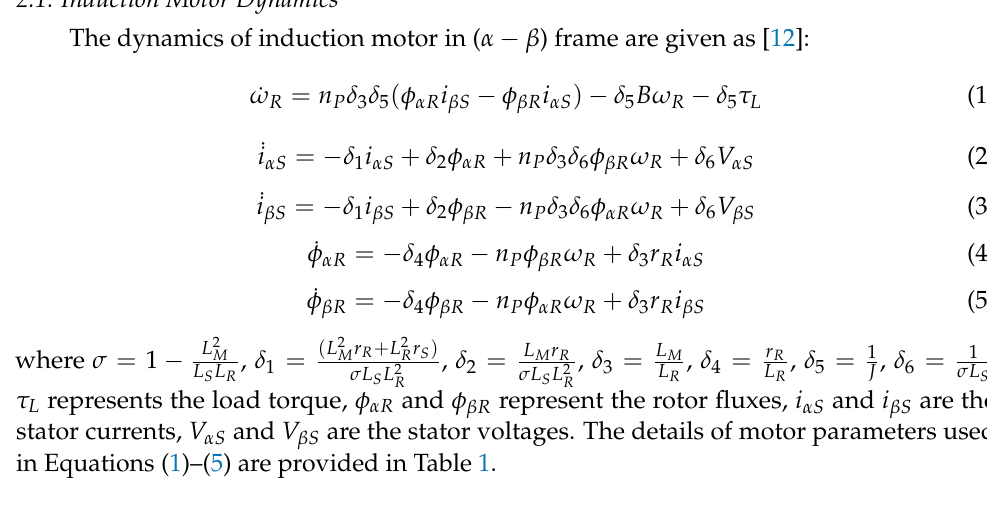
Table 1. Motor parameters. Symbol